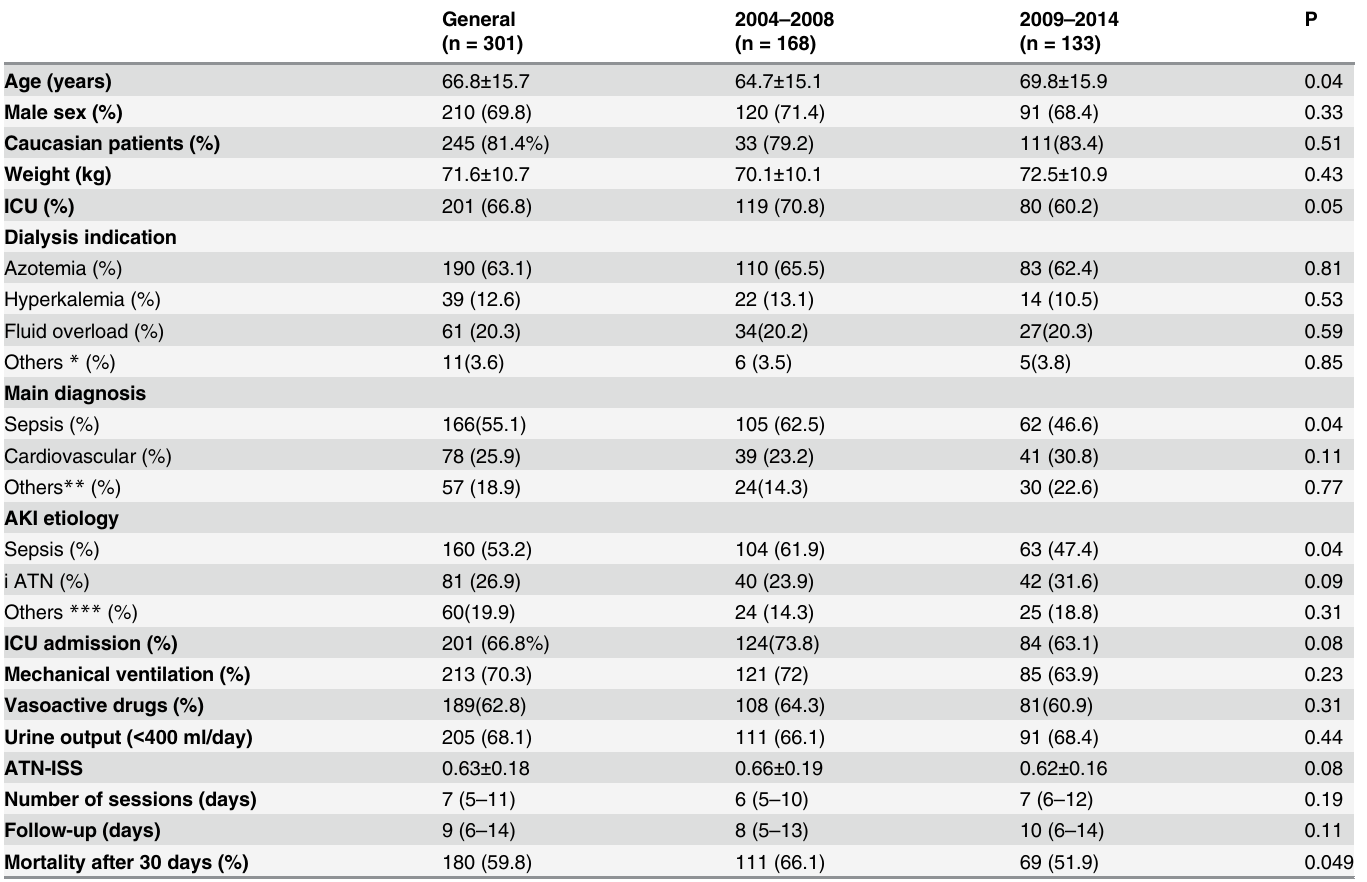
Table 1. Clinical data of acute kidney injury patient treated with high volume peritoneal dialysis according to time period of high volume peritoneal dialysis treatment.